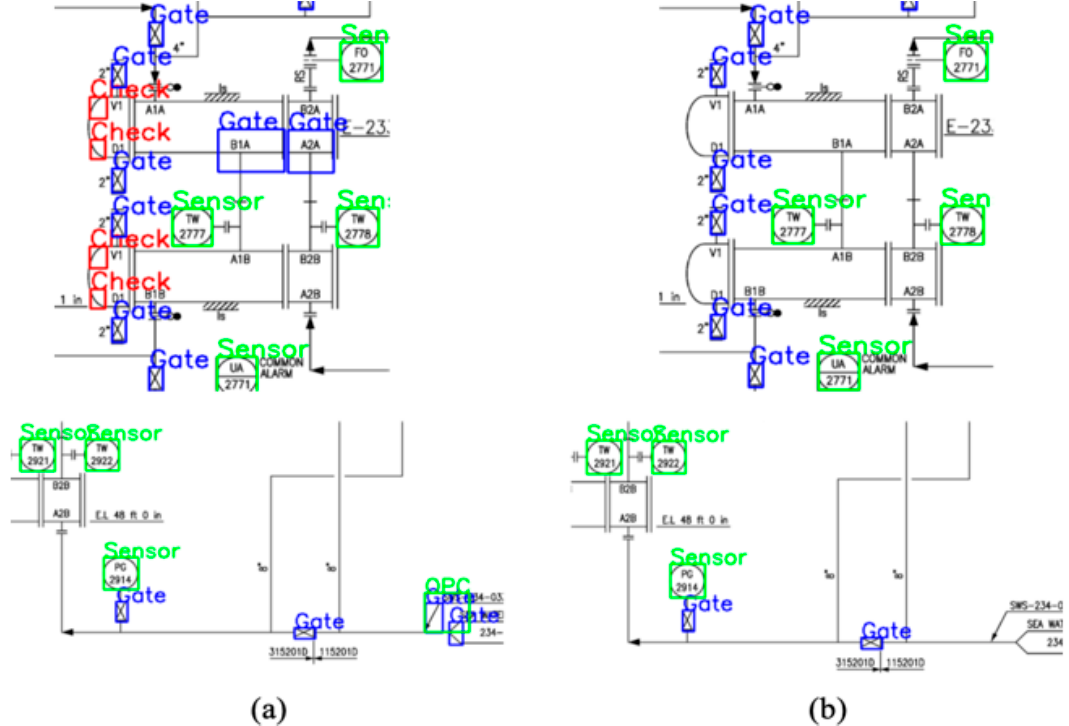
Figure 8. Sample results from the ( a ) P_model, ( b ) PN_Kmeans model.